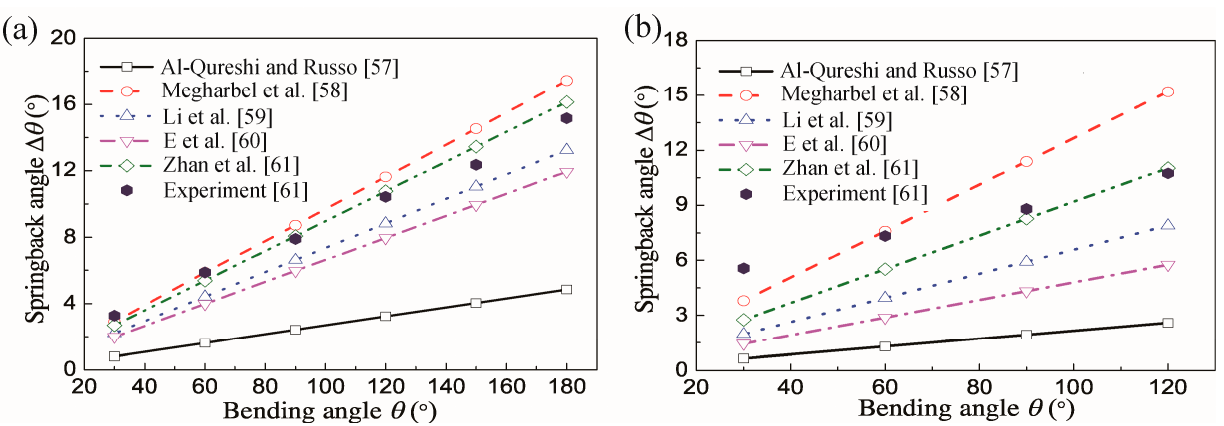
Figure 14. Analytical springback values for Ti-alloy tubes of ( a ) Ø 6 mm × 0.6 mm ( b ) Ø 12 mm × 0.9 mm [57–61]. Reproduced with permission from ref. [61]. Copyright 2016 Elsevier B.V.